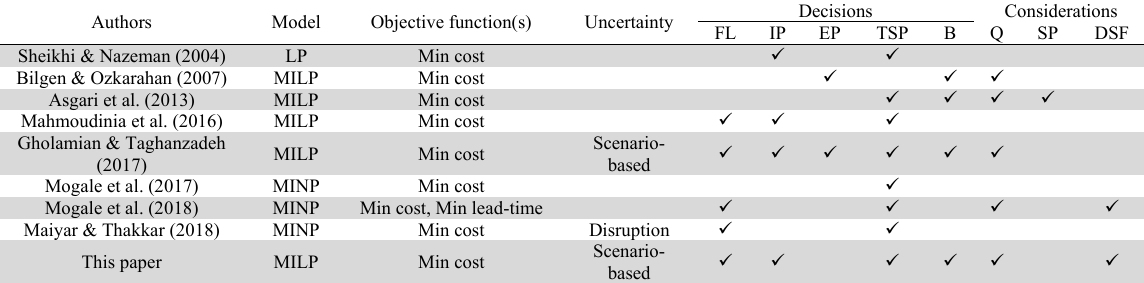
Comparison of this paper with previous studies regarding the grain and wheat supply chain Authors